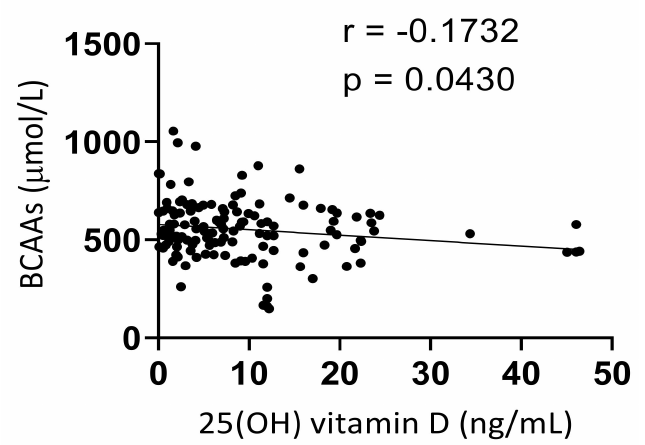
Figure 4. Correlation between serum levels of 25 (OH) vitamin D (ng/mL) and BCAAs ( µ mol/L) in patients with T2DM. r represents the Spearman’s correlation